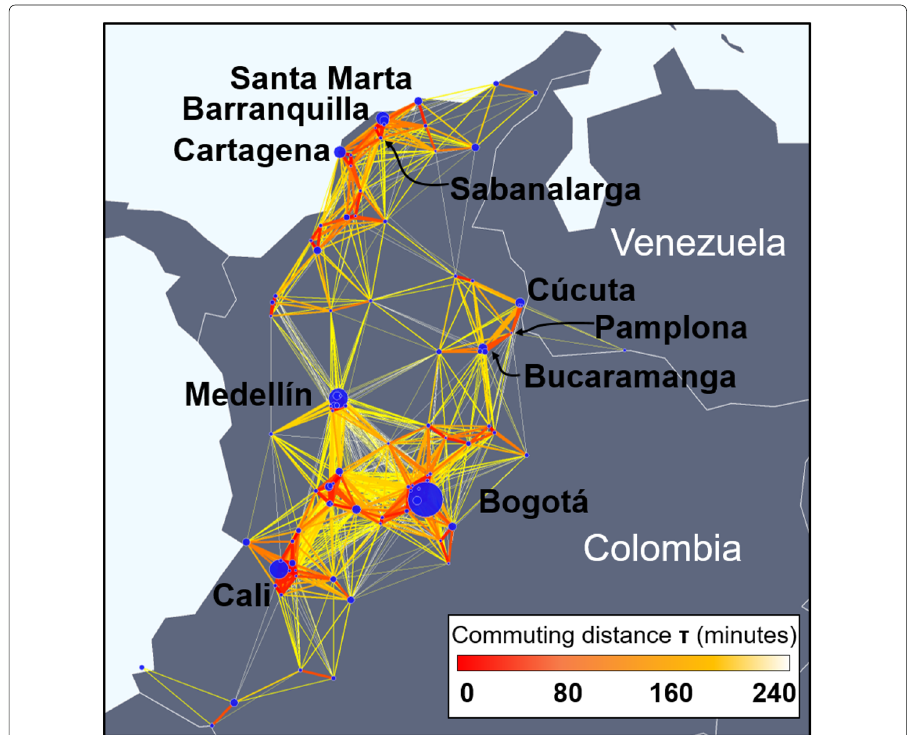
Fig. 1 Municipality commuting network, formed by the location of 96 urban municipalities in Colombia. The size of each disc represents the population of each municipality. Pairs of municipalities are connected by an edge shaded by commuting